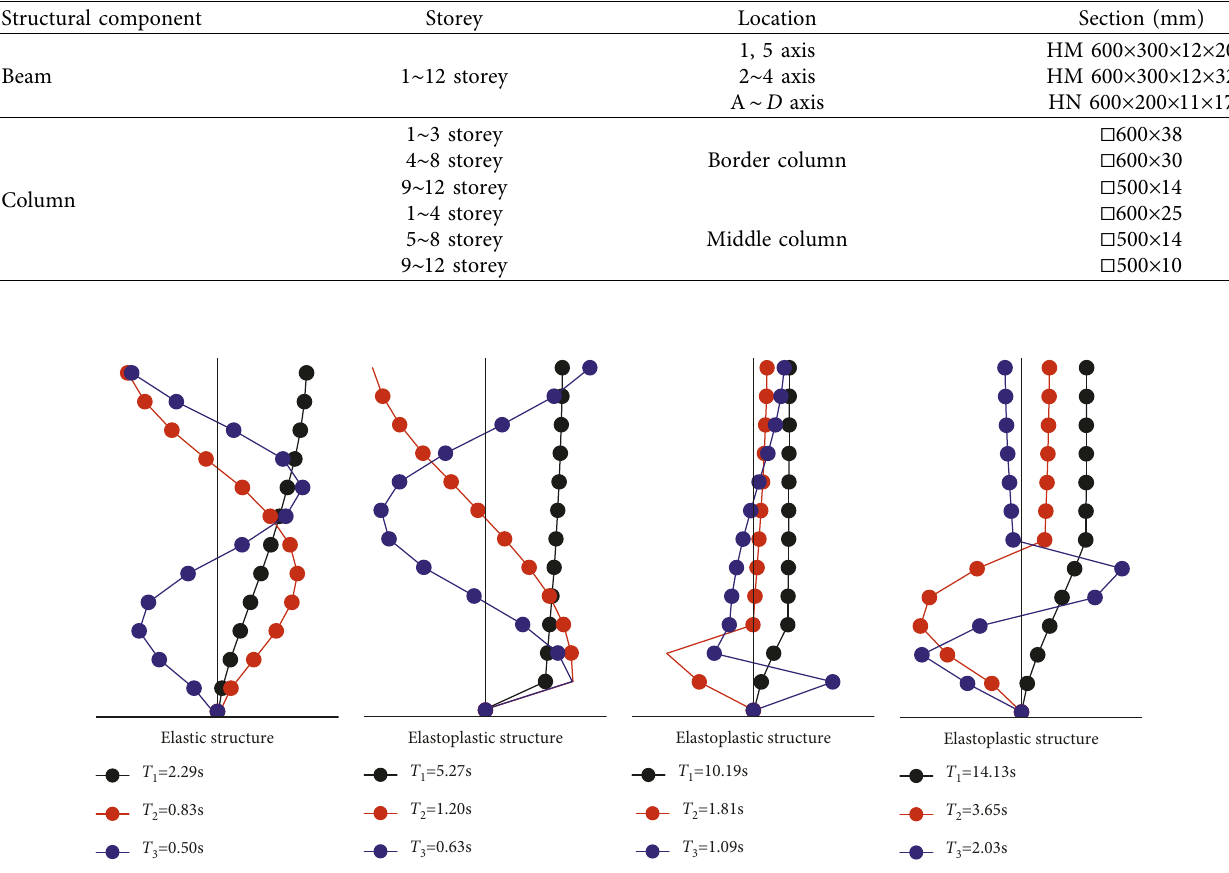
Table 2: Cross sections of beams and columns.